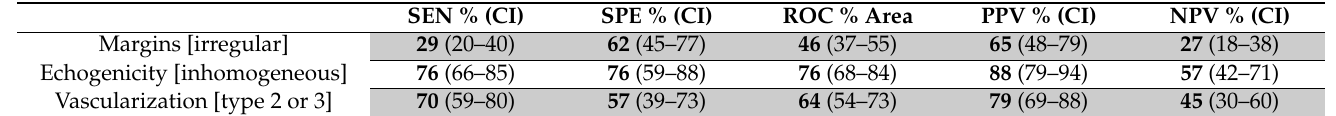
Table 3. Diagnostic values of ultrasound parameters (SEN: Sensitivity; SPE: Specificity; ROC: Receiver Operating Characteristics; PPV: Positive Predictive Value; NPV: Negative Predictive Value).